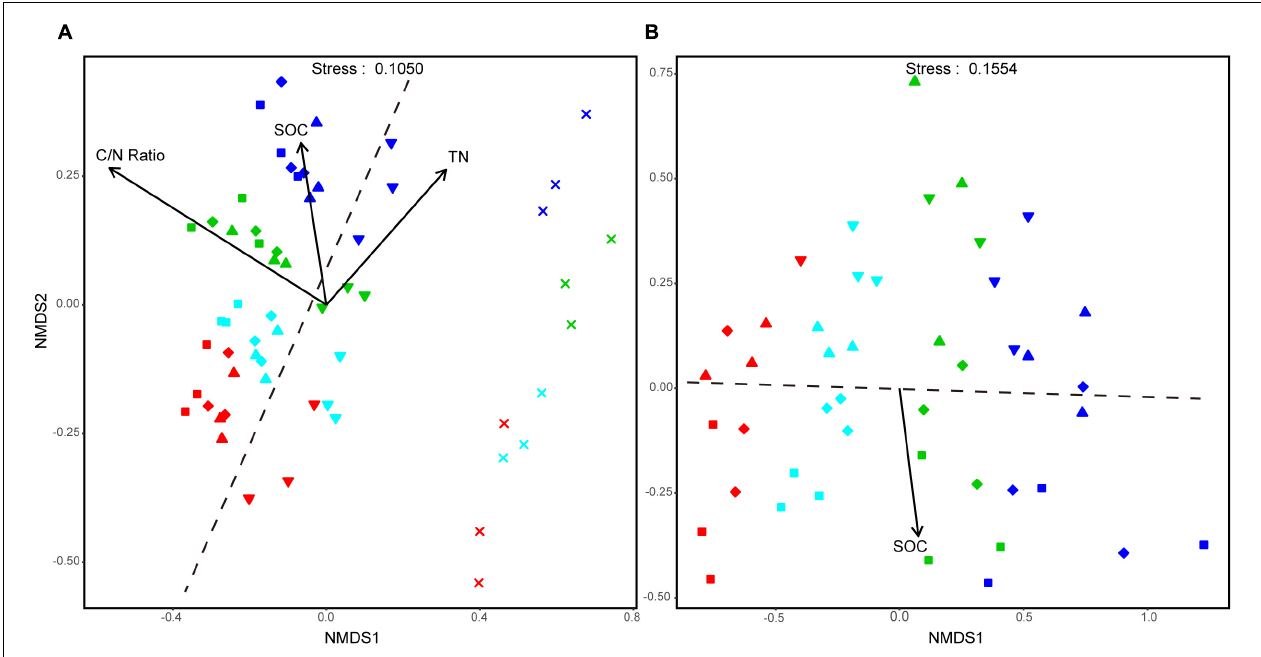
FIGURE 3 | Non-metric multidimensional scaling (NMDS) plots of all the detected samples at OTU level of the aggregate-size fractions, respectively, for the bacterial (A) and fungal community (B) . Symbols denote size fractions as follows: (cid:4) , > 2,000 µ m; (cid:7) , 2,000–250 µ m; (cid:78) , 250–53 µ m; (cid:72) , 53–2 µ m; × , < 2 µ m. Colors denote treatments as follows: red, NF; green, CF; blue, CFM; black, CFS. Dotted lines, respectively, indicate the boundary between MicA and F-MicA in A while between MacA and MicA in panel B